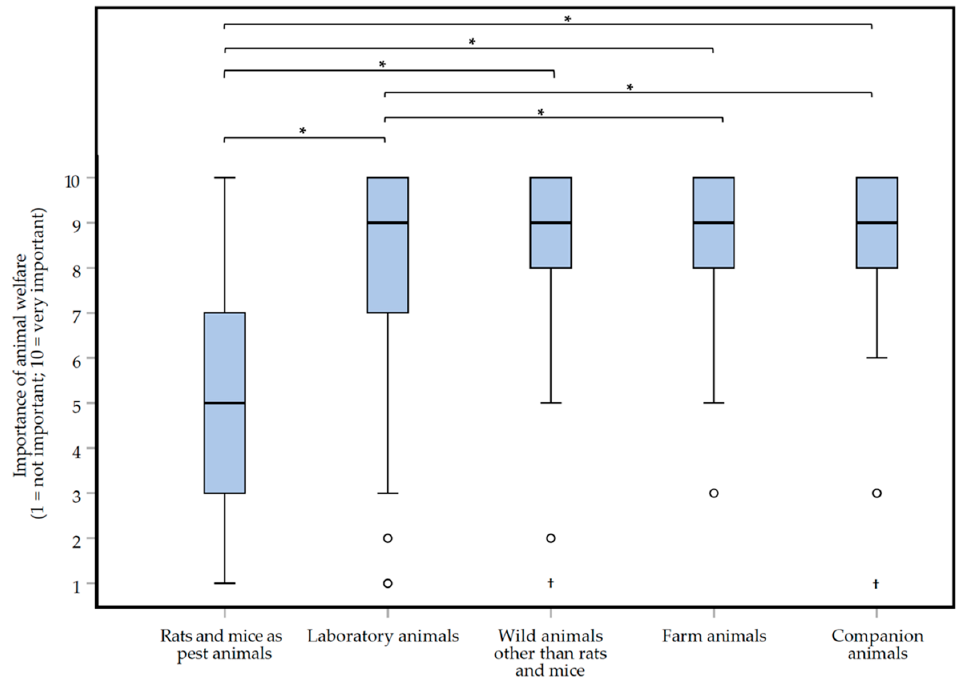
Figure 4. Box plots presenting the scored importance of animal welfare for five different categories of animals according to 129 Dutch pest controllers participating in an online survey about the treatment of rats ( Rattus rattus and Rattus norvegicus ) and mice ( Mus musculus ). The importance could be indicated on a 1 (not important) to 10 (very important) interval rating scale. Outliers and extreme cases are indicated with o and †, respectively. Statistically signi fi cant di ff erences between two animal categories are indicated with *.